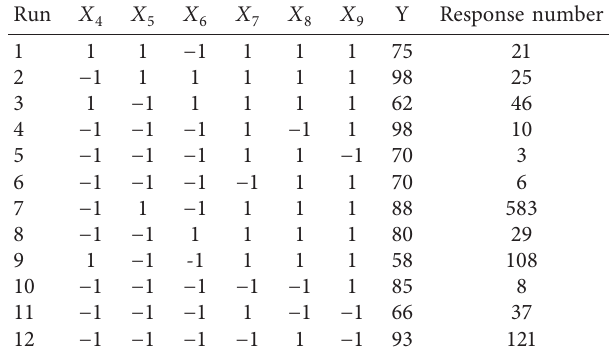
Table 6: One replicate for Example 2.